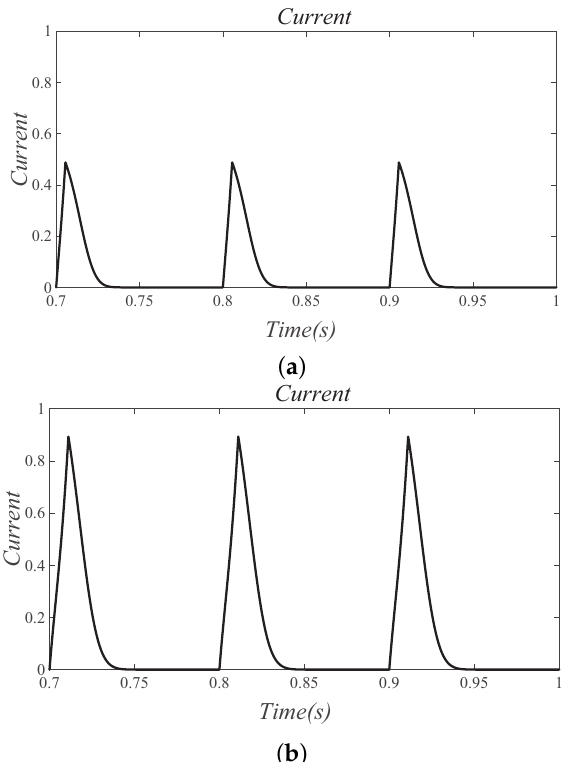
Figure 16. ( a ) Current in the machine with ( a ) alternate excitation mode, ( b ) bipole excitation